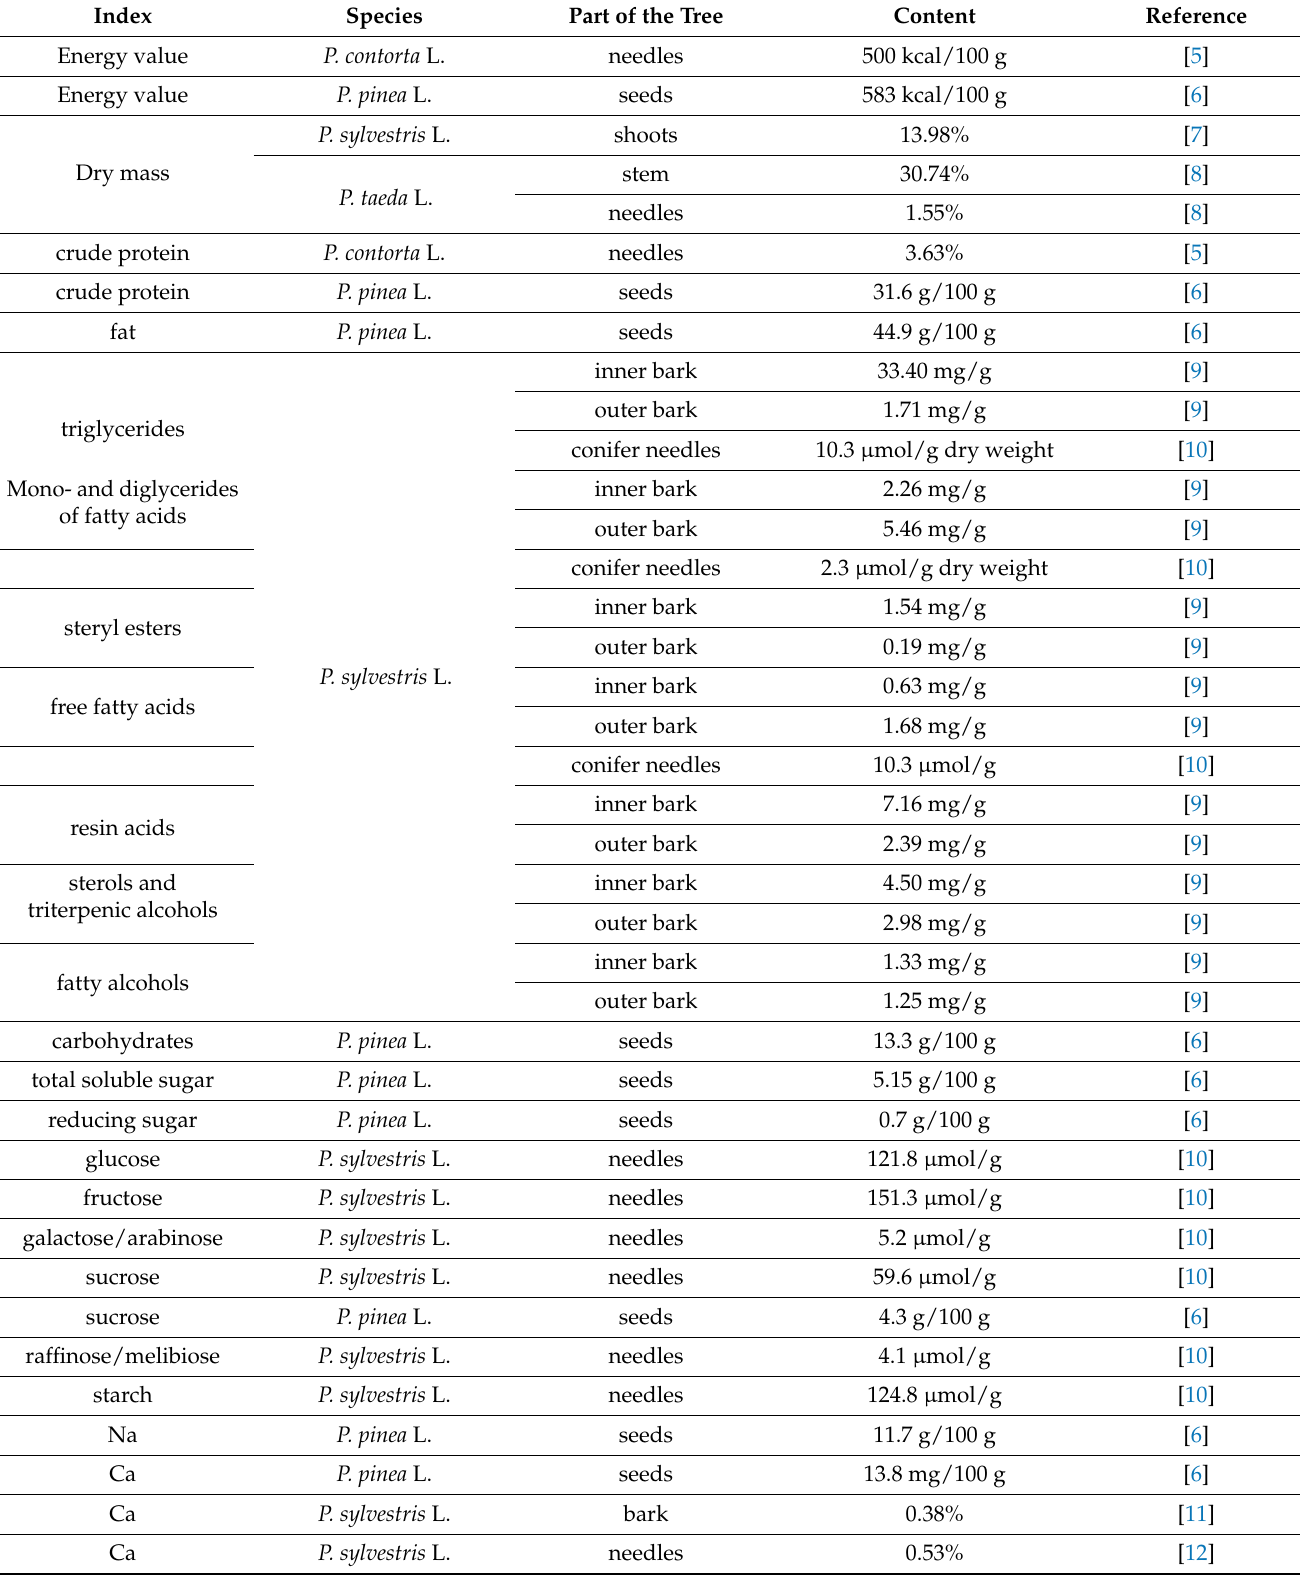
Table 3. Nutritional value and mineral